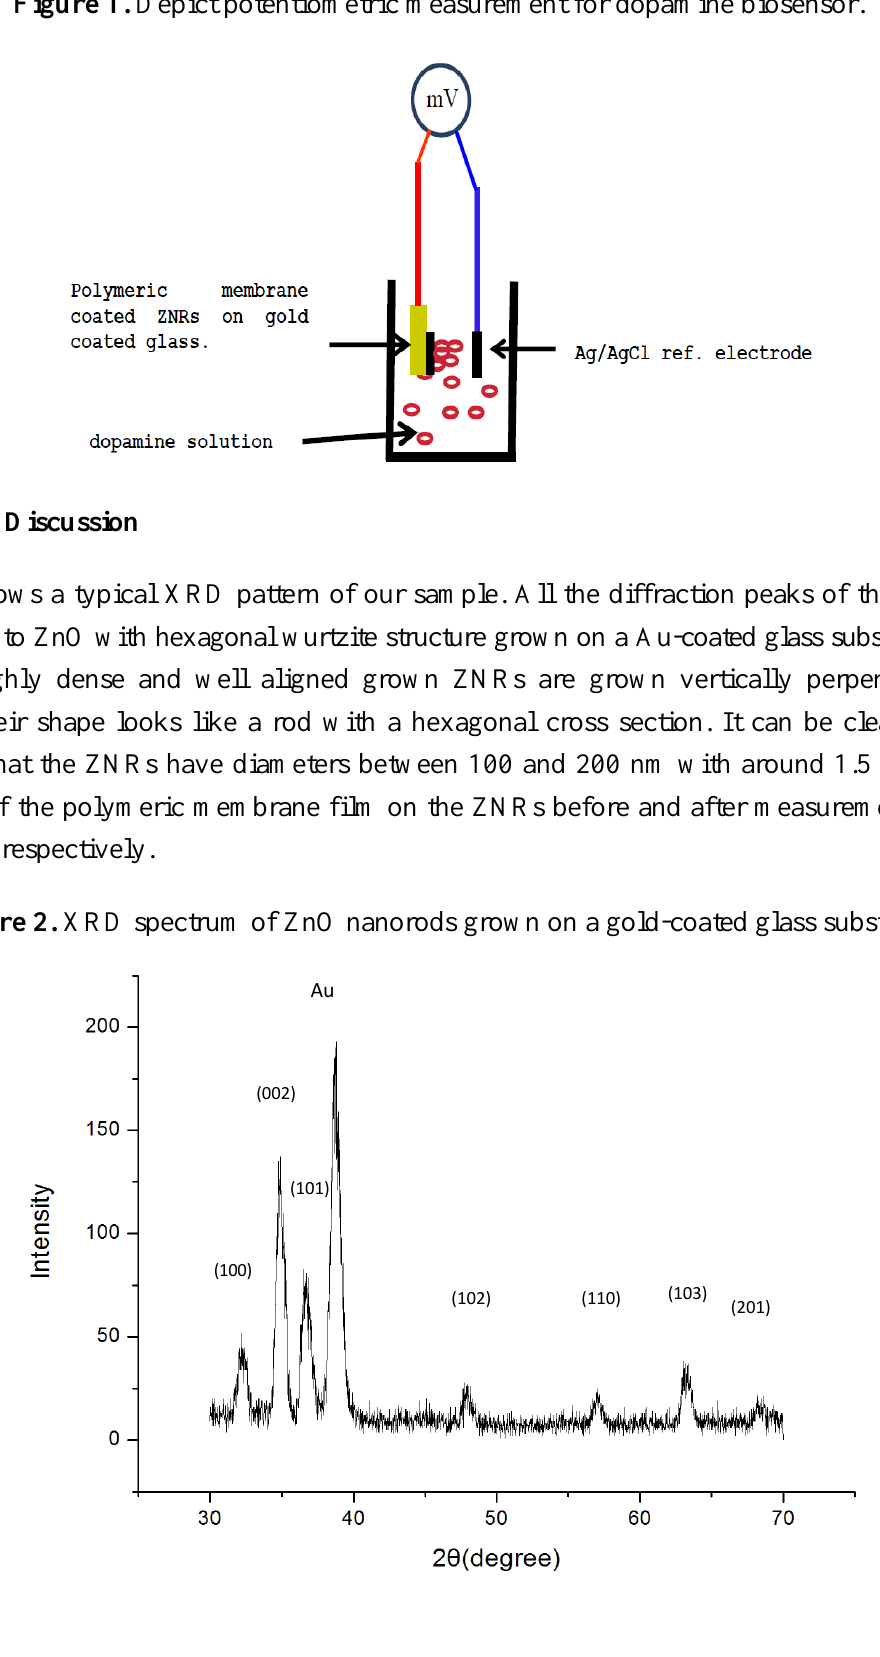
Figure 1. Depict potentiometric measurement for dopamine biosensor.